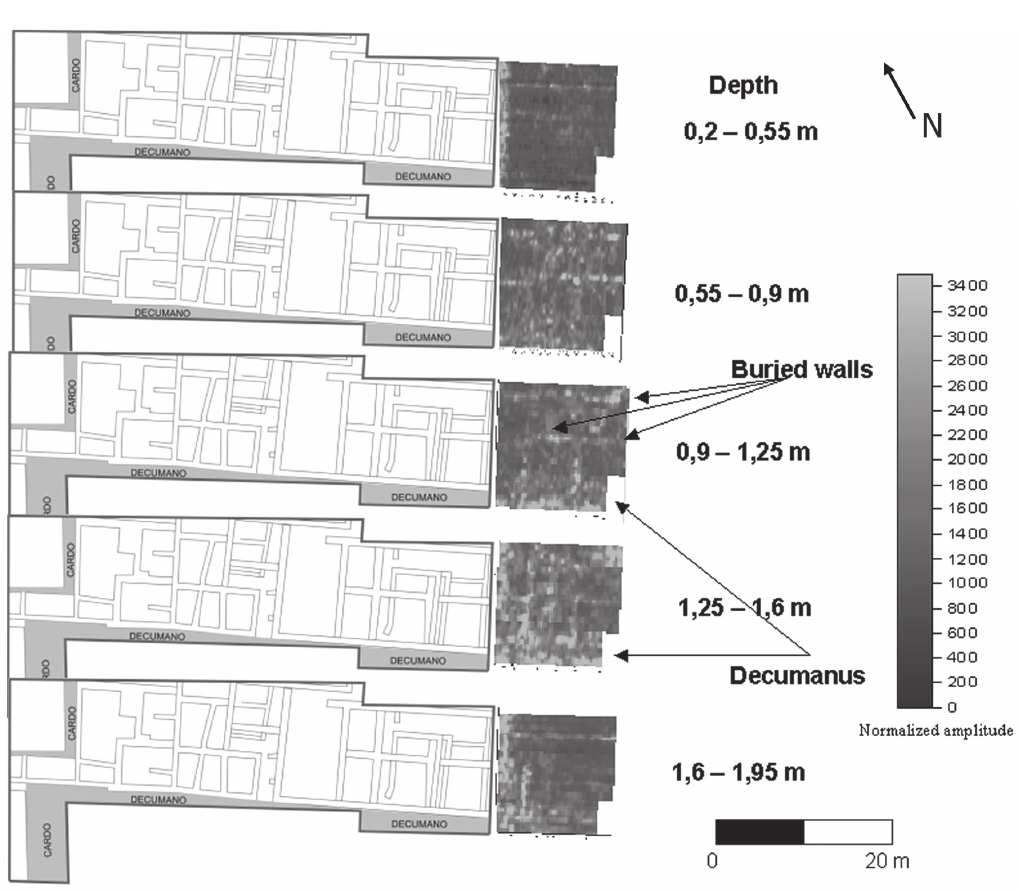
Fig. 6. GPR time-slices obtained for a depth ranging from 0.2 m to 1.95 m in area 1. SW elongated anomalies at depths from 0.55 m to 0.9 m seem continuing the structures of the adjacent excavation. These ones are well visible down to 1.6 m depth. The depth slices relative to the depth of 1.25 m 1.6 m disclose the effect of the presence of the